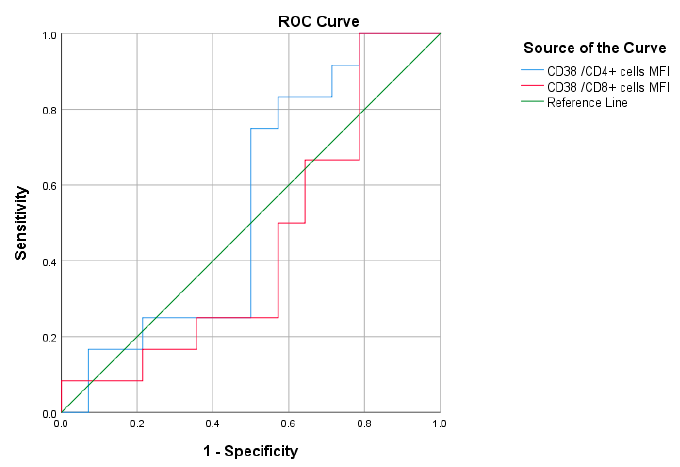
Figure 8. ROC curve of CD38/CD4 + cells and CD38/CD8 + cells to predict mortality among patients of the severe/critical group. Table 11. ROC analysis of CD38/CD4 + cells and CD38/CD8 + cells to predict mortality among patients of the severe/critical group.